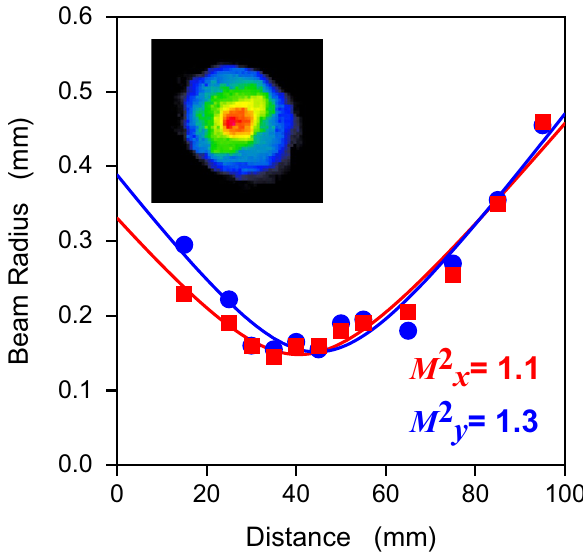
Figure 7. Beam propagation and intensity profile (far field).